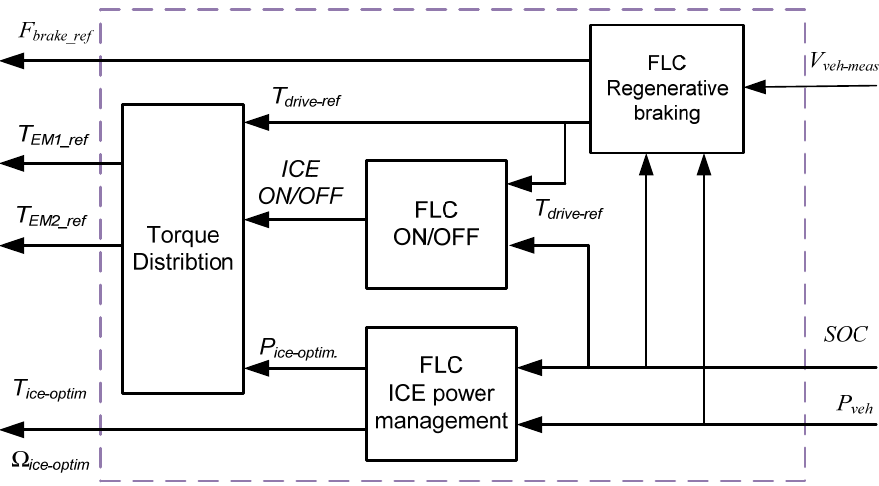
Figure 2. Diagram for the global FLC strategy of the HEV with